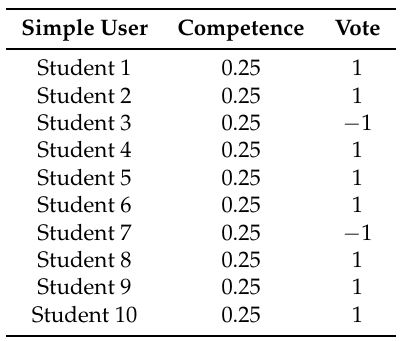
Table 5. Decision-making Simple User.